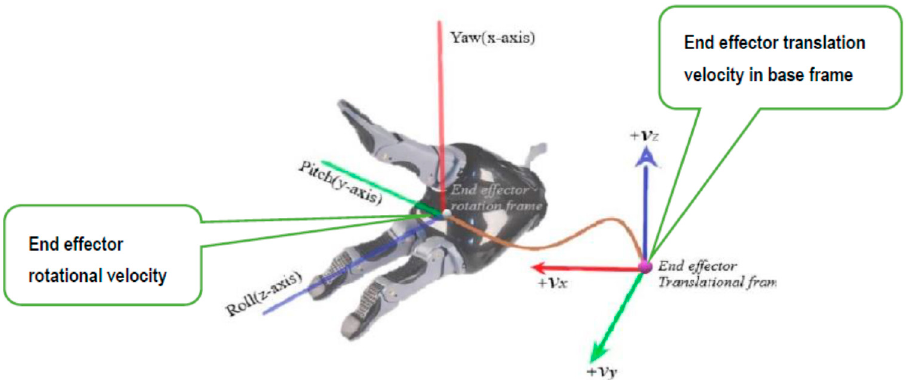
Figure 6. The velocity of the end effector in the Mixed frame configurations.